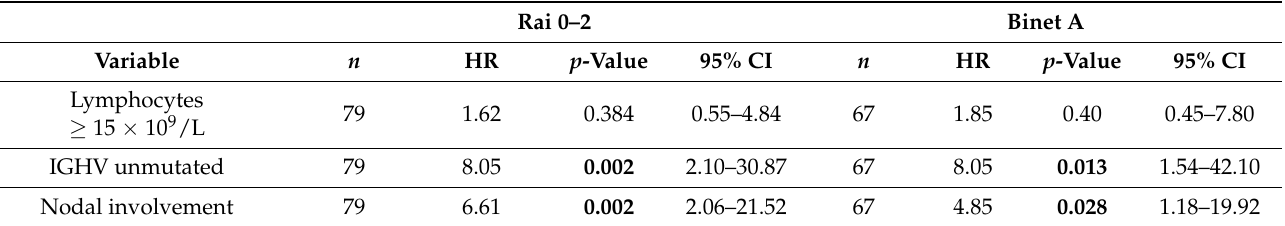
Table 3. Multivariate analysis of variables for TTFT of early stage CLL patients according to the IPS-E score [19]. Rai stages 0–2 and Binet stage A were considered as early stages. Significant values (according to the Cox regression) are shown in bold. Rai 0–2 Binet